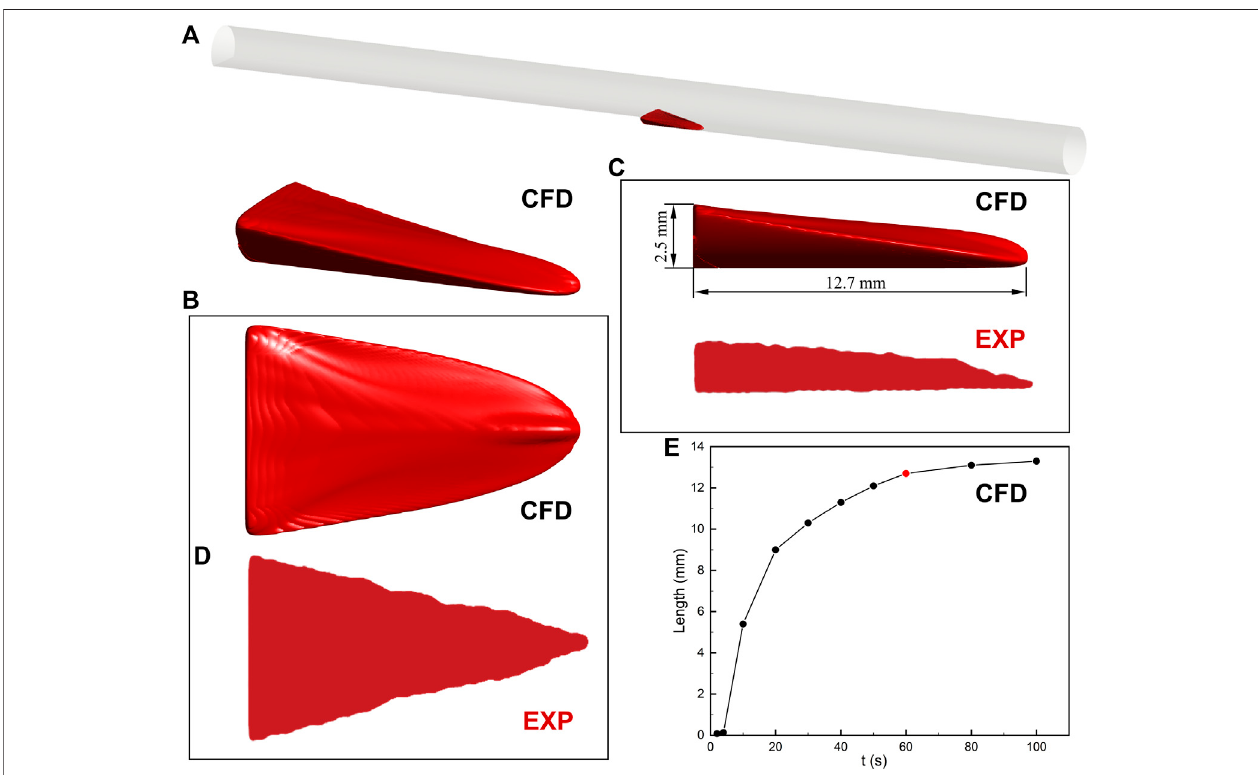
FIGURE3| Thrombusformationinthebackward-facingstepmodel. (A) Schematicdiagramofthelocationofthethrombus. (B) 3Dthrombusshape.CFDrefersto the result of computational prediction. (C) Side view with height and length of thrombus. The prediction of the thrombus model is in acceptable agreement with the experimental result (EXP). (D) Top view. The difference in the thrombus shape may result from the contrast agent and MRI resolution. (E) The relationship between the axial length of thrombus and simulation time. The increase in thrombus length is negligible after 60 s. The insets of the thrombus come from experimental observation (Yang et al.,